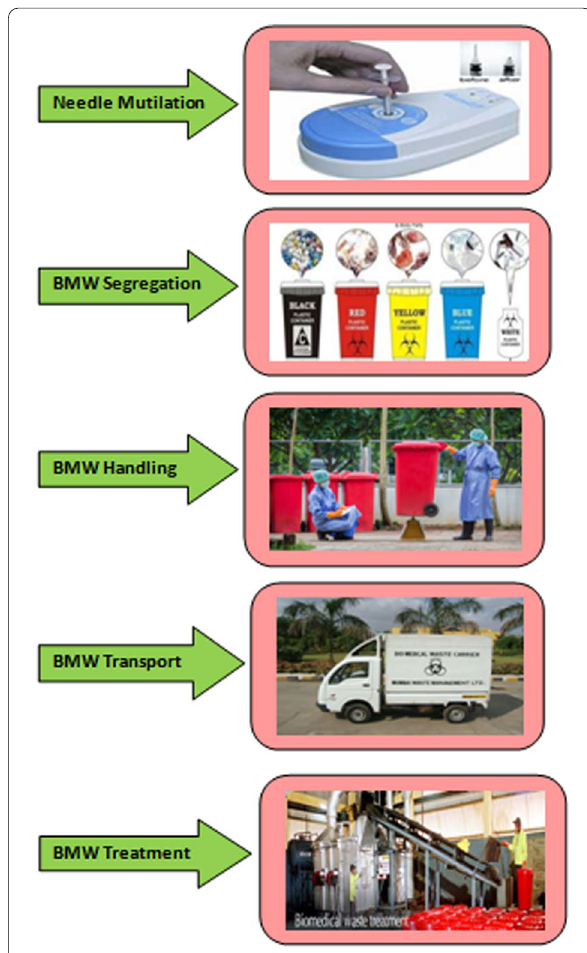
Fig. 1 Steps involved in biomedical waste management. Source : Central Pollution Control Board